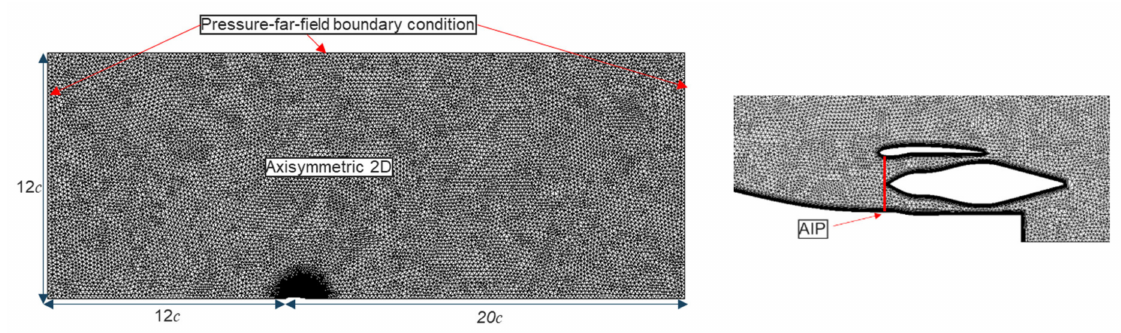
Figure 4. Computation domain mesh generated for the 2D